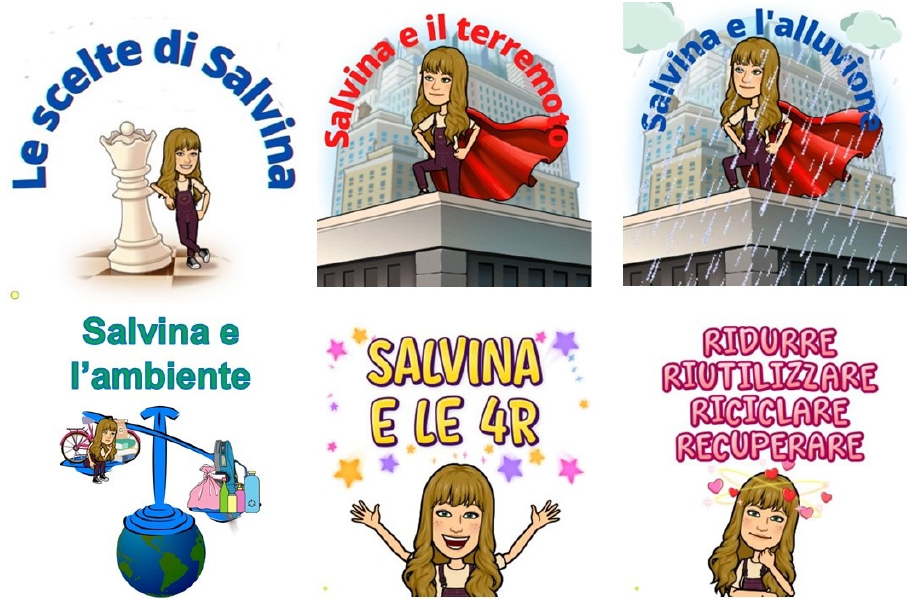
Figure 1. Representative images of Salvina’s adventure games logo collections.